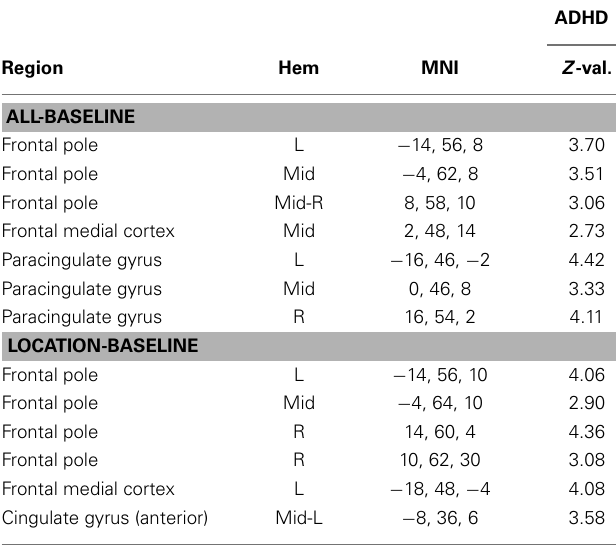
Table 8 | Inattentive symptoms association with BOLD signal